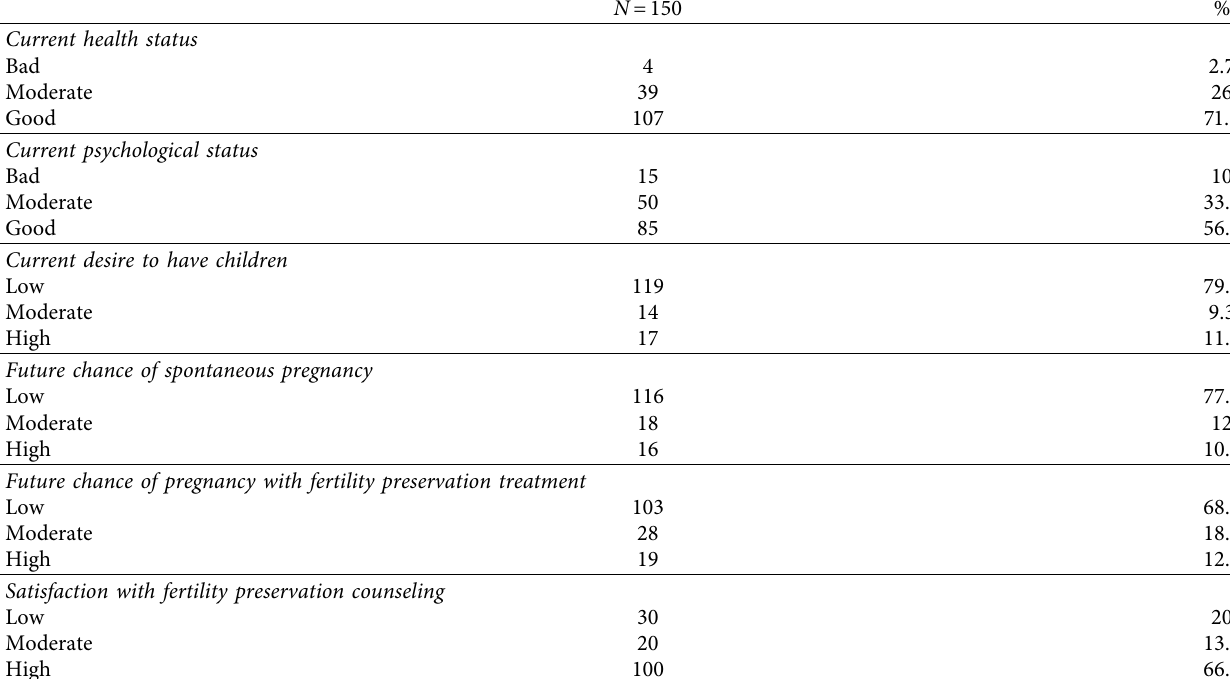
Table 2: Te current health and psychological statuses, future chance of pregnancy with or without fertility preservation treatment, and satisfaction with counseling among the